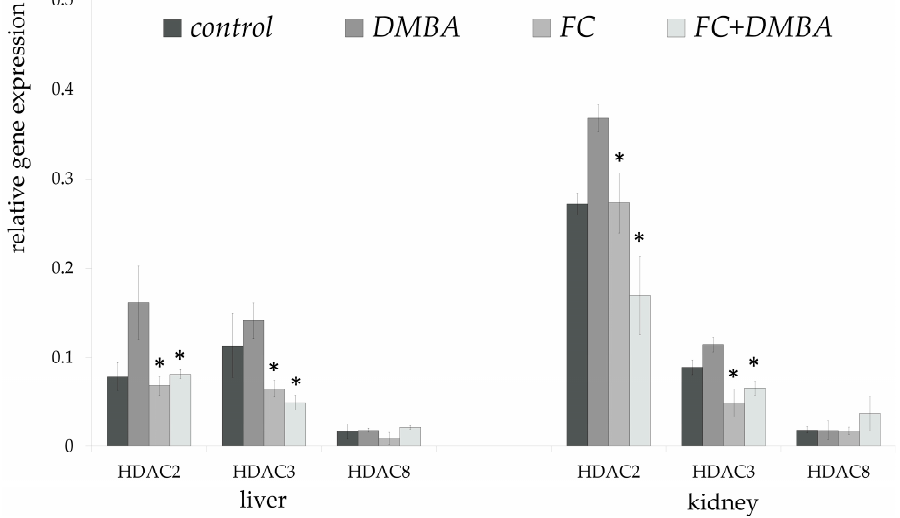
Figure 4. Relative gene expression of HDAC genes. The relative gene expression levels of histone deacetylases at the mRNA level in the liver and kidney of experimental animals relative to the mRNA levels of HPRT1 (DMBA: 7,12-dimethylbenz(a)anthracene, HPcFE: fruit seed and peel ex- tract); * signi fi cantly di ff erent from DMBA-treated mice ( p < 0.05). Error bars represent the standard deviation.